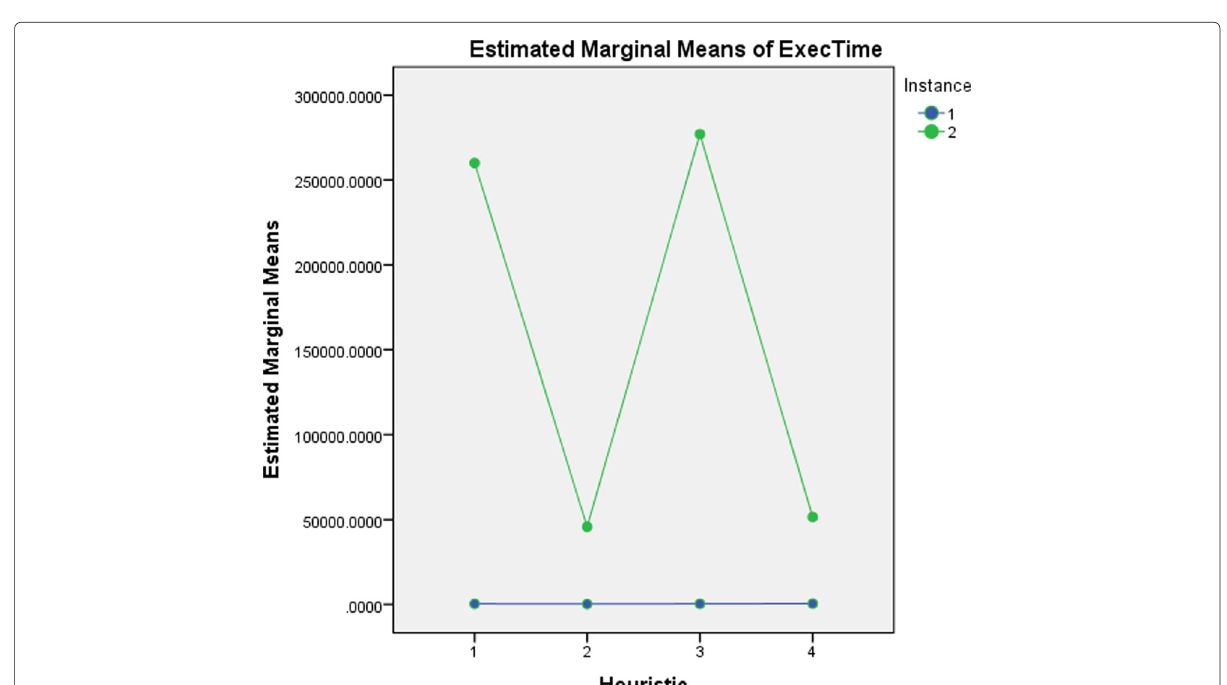
Fig. 14 Robustness of solution -